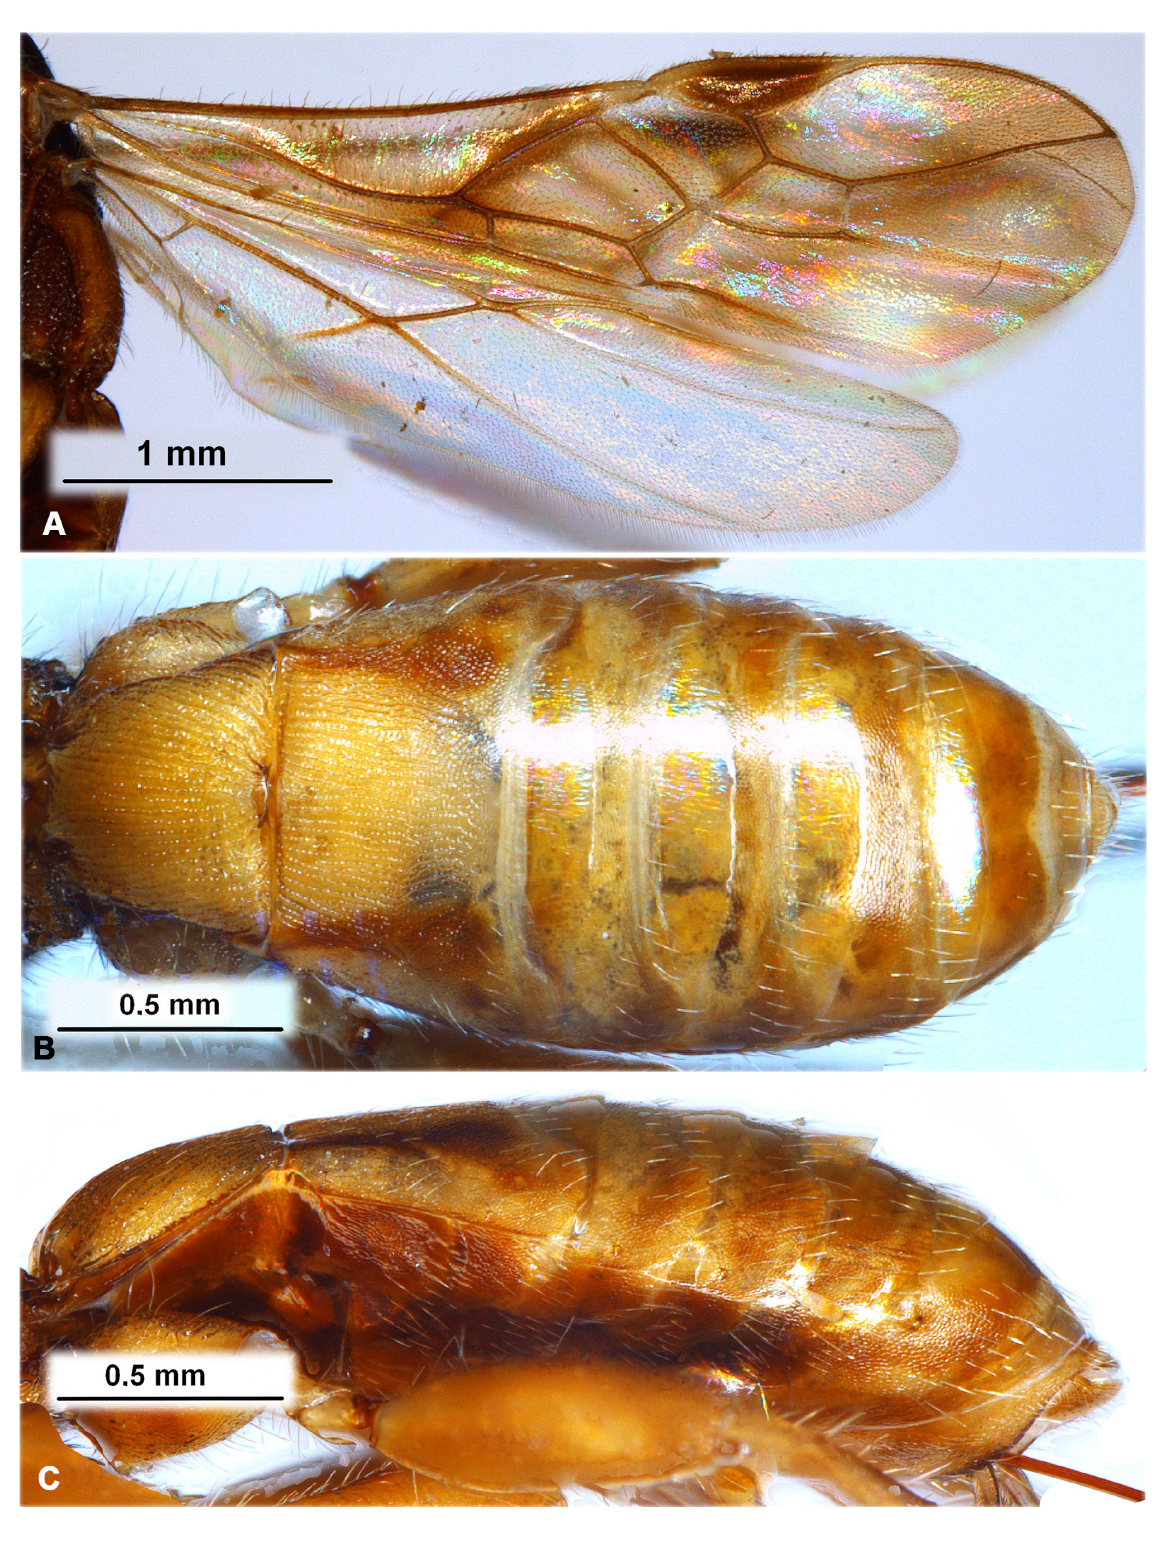
Fig. 8. Doryctes ( Neodoryctes ) arrujumi Belokobylskij sp. nov., holotype, ♀ (RMNH). A . Wings. B . Metasoma, dorsal view. C . Metasoma, lateral